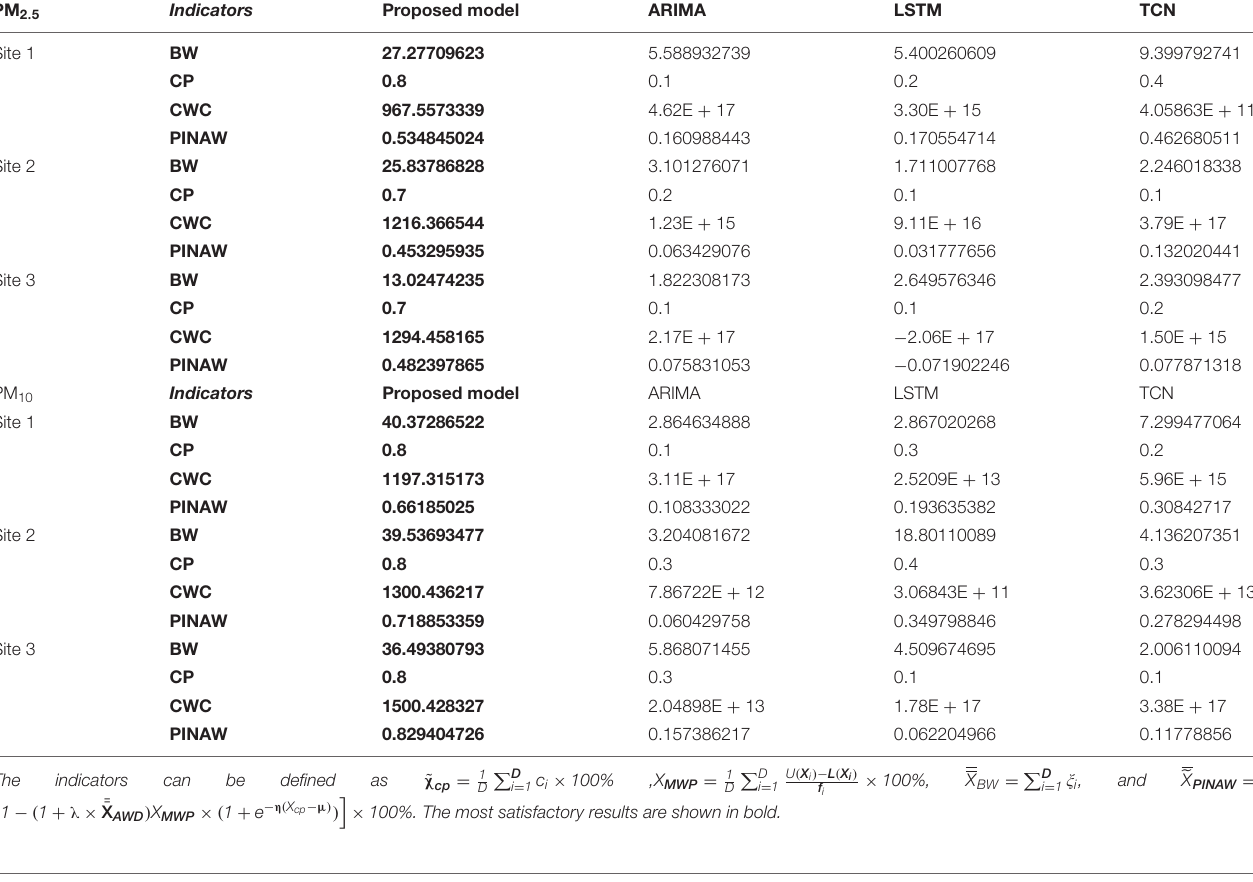
TABLE 8 | Interval forecasting results of the proposed system for daily PM 2 . 5 and PM 10 concentrations of Beijing, Shanghai, and Shenzhen. PM 2 . 5